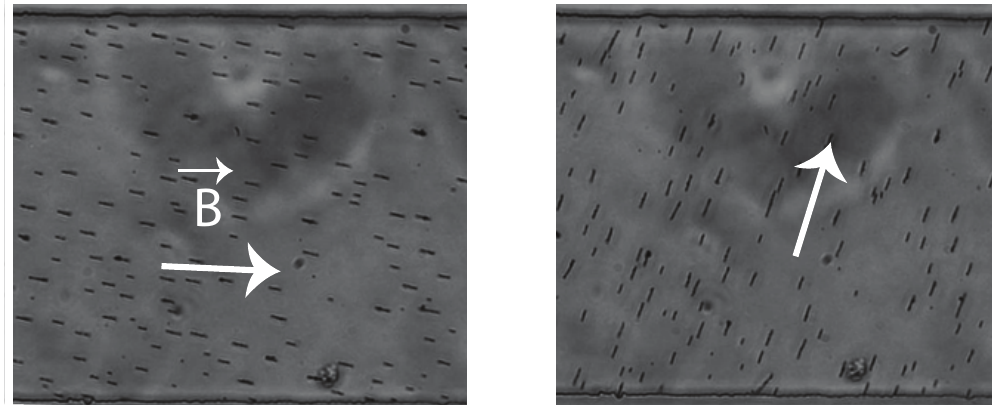
Figure 8. Photographs of suspensions of short fibers with an imposed orientation using an external magnet.